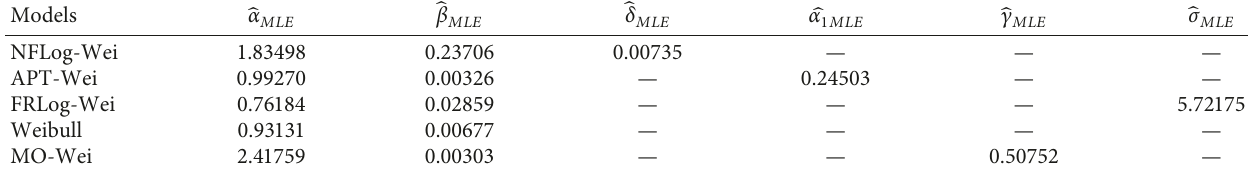
, 􏽢 β , 􏽢 δ , 􏽢 α , 􏽢 c MLE MLE MLE , and MLE 1 MLE